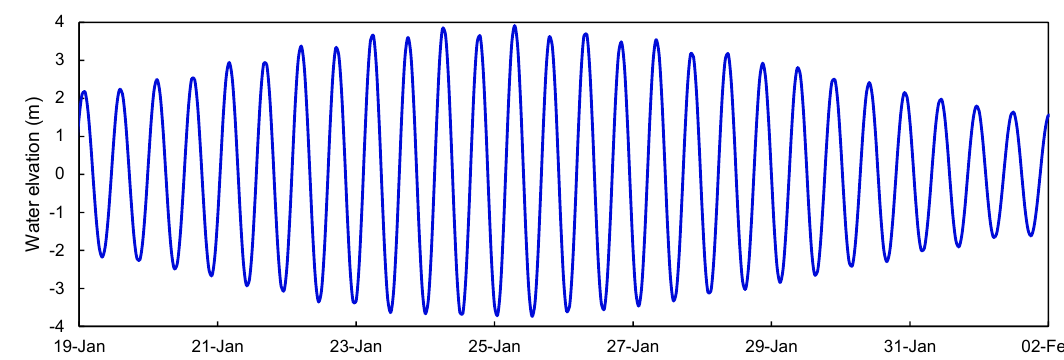
Figure 4. Water elevation time-series at the open boundary covering a full neap-spring tidal cycle.